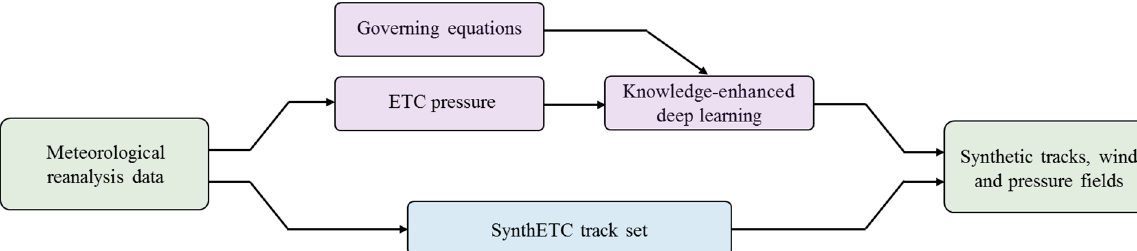
Figure 4. Schematic of knowledge-enhanced deep learning for the simulation of ETC wind